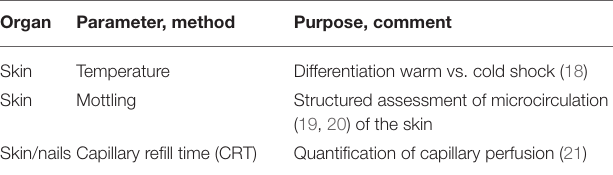
TABLE 2 | Structured clinical investigation of micro-circulation. Organ Parameter, method Purpose,